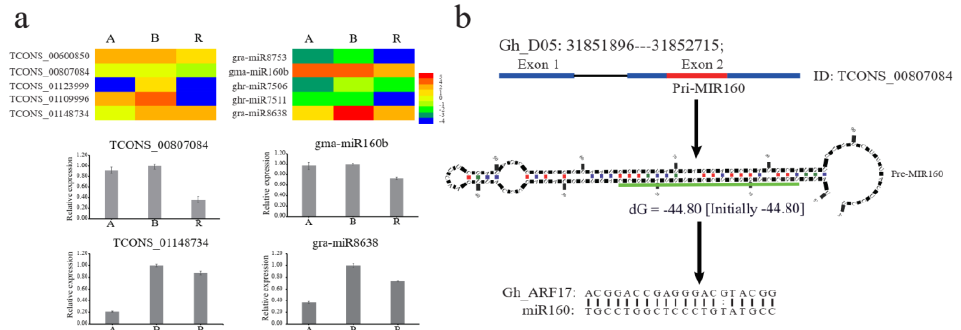
Figure 4. LncRNAs acting as endogenous target mimics (eTMs) of miRNAs in anther development of cotton. ( a ) The prediction lncRNAs as eTMs of ath-miR171c-5p and ath-miR399b in cotton; ( b ) Sequence alignment of eTMs for ath-miR171c-5p and ath-miR399b in cotton, Arabidopsis, and rice.